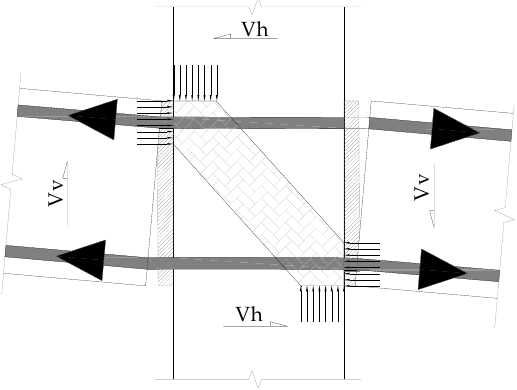
Figure 21. Shear transfer by the diagonal compression strut.